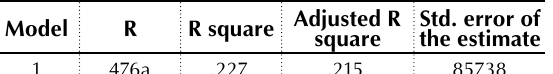
Table 5. Correlation analysis between social media marketing strategies and functional